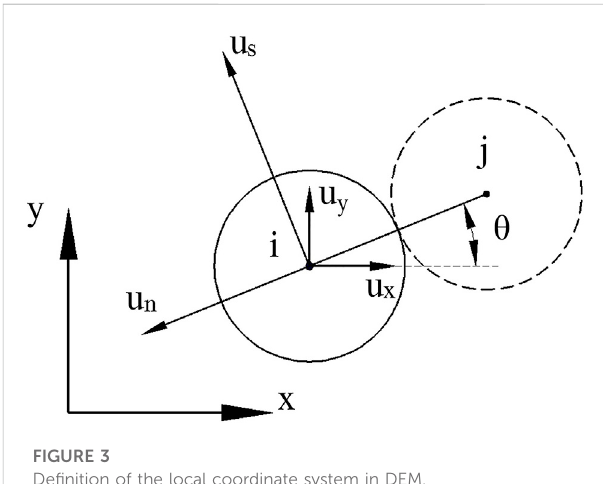
FIGURE 3 De fi nition of the local coordinate system in